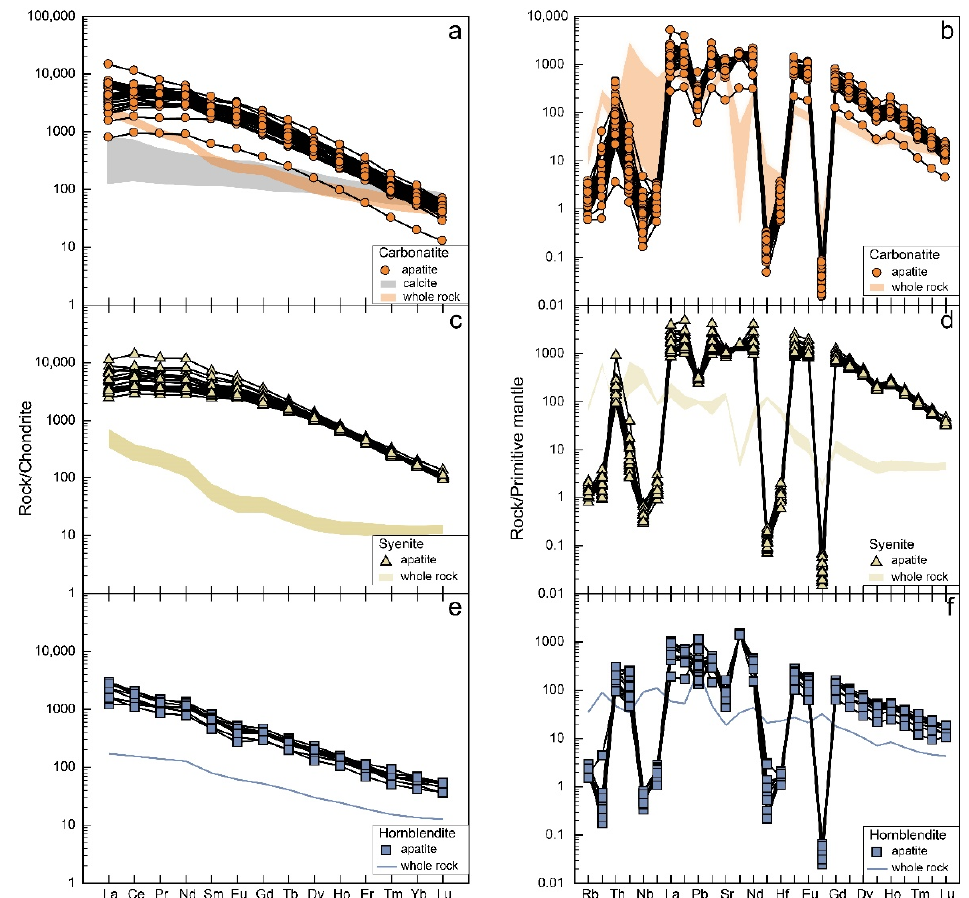
Figure 3. Chondrite-normalized REE patterns ( a , c , e ) and primitive mantle-normalized trace element diagrams ( b , d , f ) of the SXD carbonatite, syenite, and hornblendite. Chondrite and primitive mantle values are from Anders and Grevesse [55] and Sun and McDonough [56], respectively. The REE data of calcite are from Xu et al. [37] and Chen et al. [38].